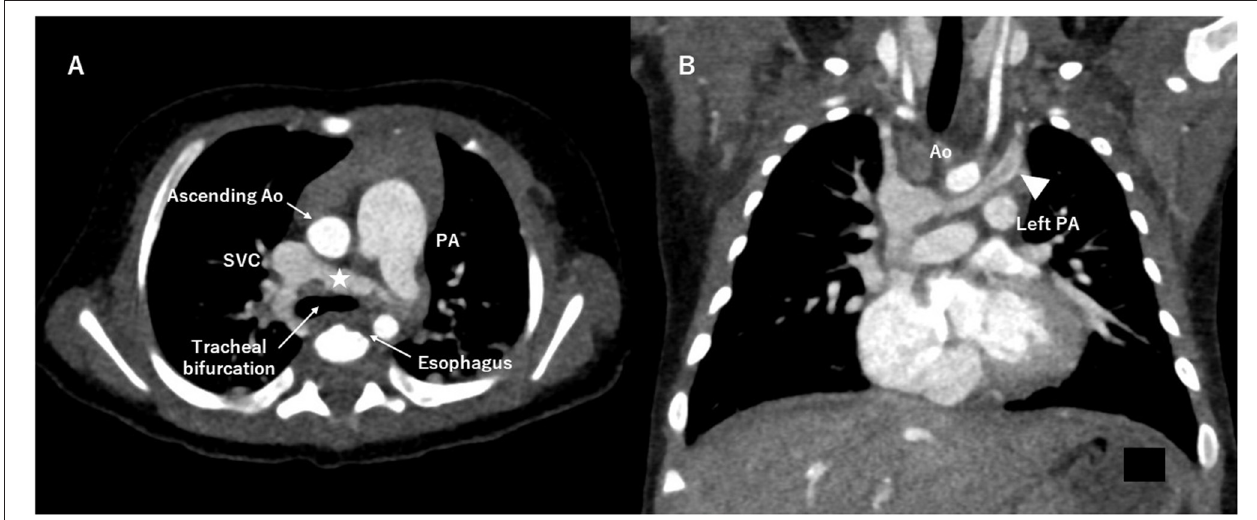
FIGURE 3 | Computed tomography angiography. (A) The retroaortic innominate vein (RAIV, asterisk) runs near the tracheal bifurcation and the esophagus. (B) The descending portion of the RAIV (arrowhead) is similar to a persistent left superior vena cava. Ao indicates aorta; PA, pulmonary artery; SVC, superior vena cava.